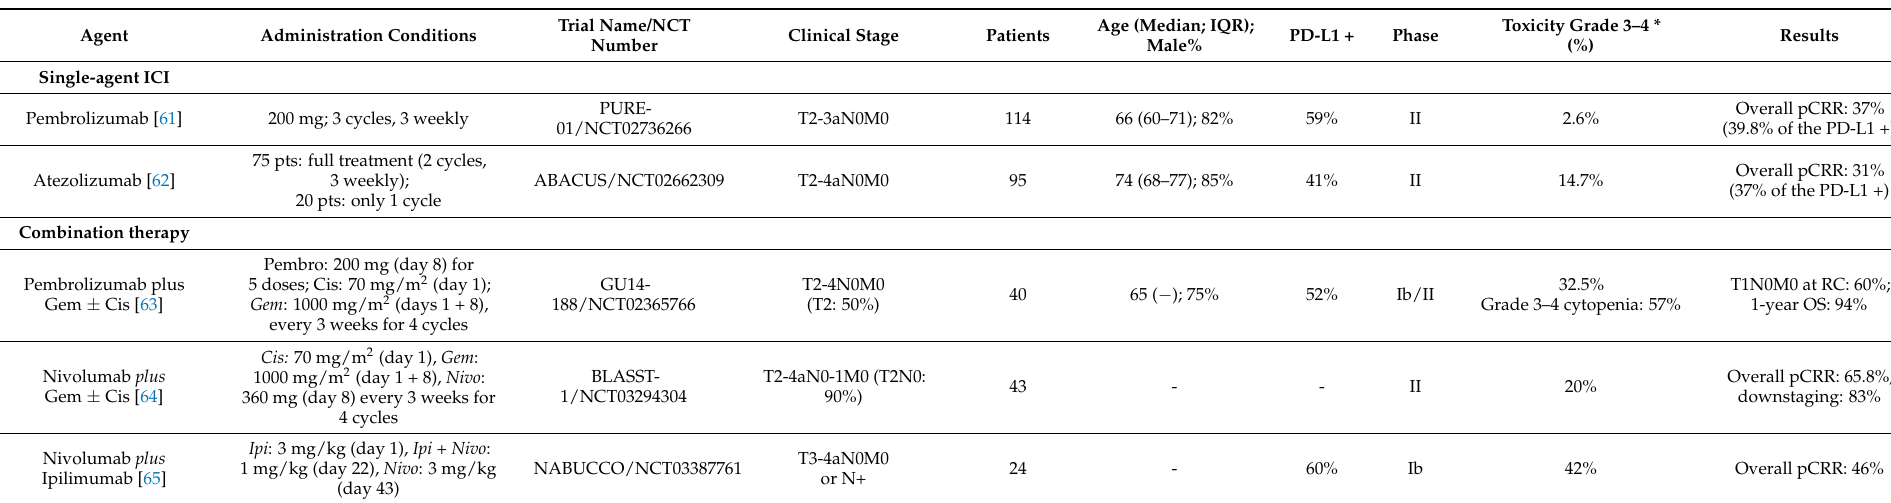
Table 1. Neoadjuvant clinical